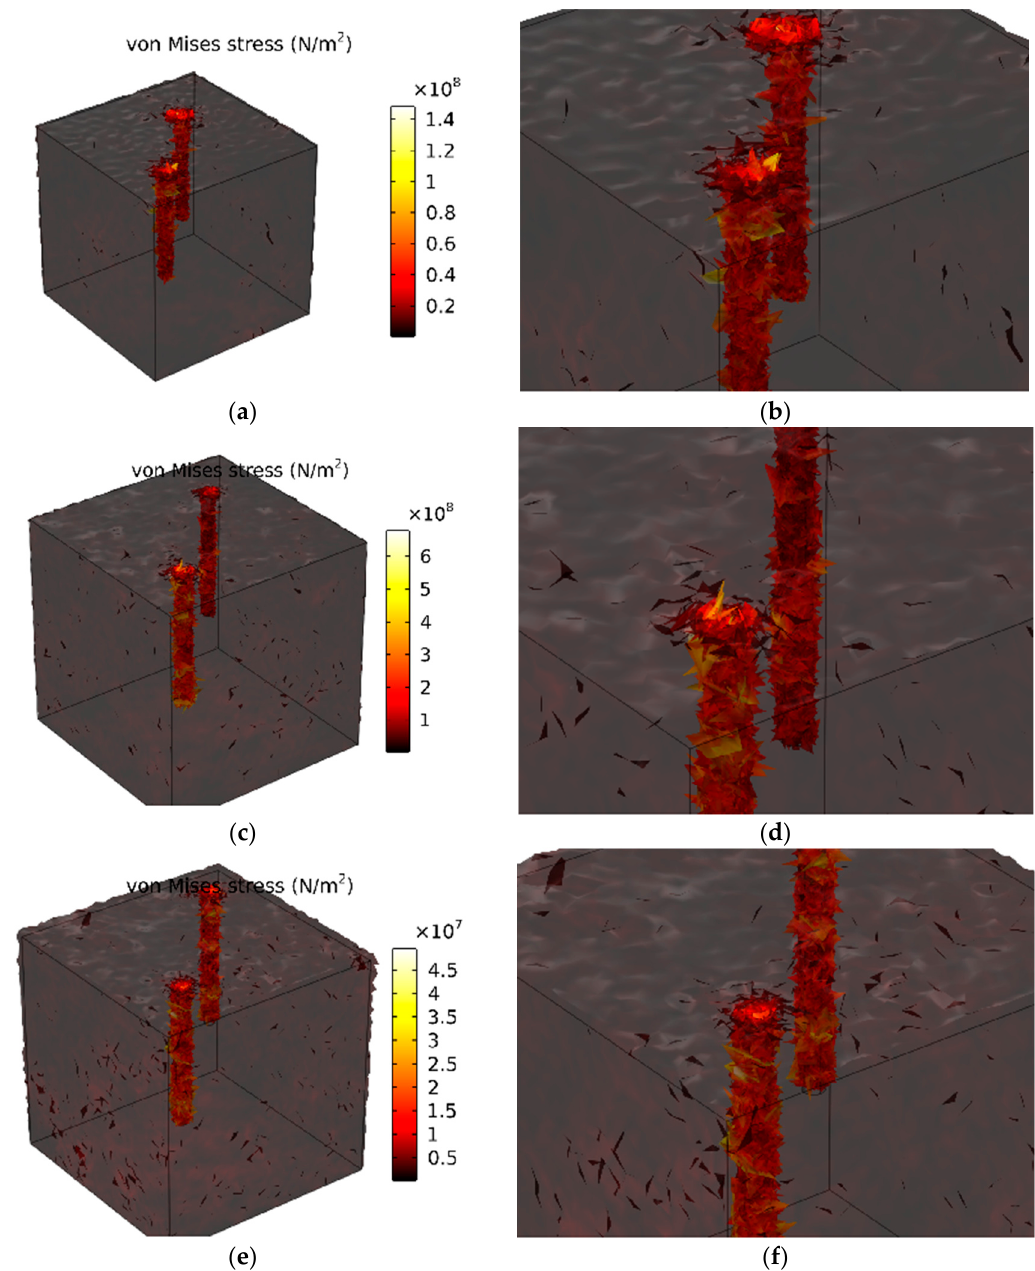
Figure 6. Stress shadow effect represented by an equal-effect stress field with different hole spacings. ( a ) Equivalent stress field of 0.12 m borehole with 3 m spacing. ( b ) Equivalent stress field of 0.12 m borehole with 3 m spacing (details). ( c ) Equivalent stress field of 0.12 m borehole with 3.5 m spacing. ( d ) Equivalent stress field of 0.12 m borehole with 3.5 m spacing (details). ( e ) Equivalent stress field of 0.12 m borehole with 4 m spacing. ( f ) Equivalent stress field of 0.12 m borehole with 4 m spacing (details).